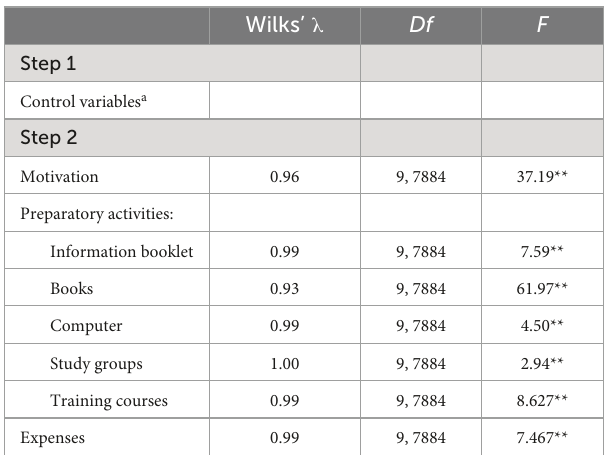
TABLE 6 Hierarchical multivariate multiple regression analysis predicting the nine